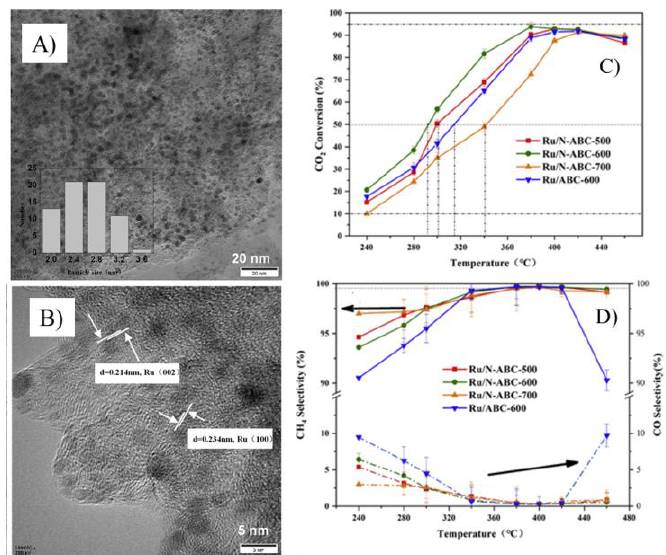
Figure 5. Ni nanoparticles supported on carbon nanotubes (CNTs) as catalyst for the methanation reaction ( a ) and ( b ). CO conversion and CH 4 selectivity, ( c ) and ( d ), for selected Ni-CNT catalysts. Reproduced from [86] with permission of The Royal Society of Chemistry 2020.